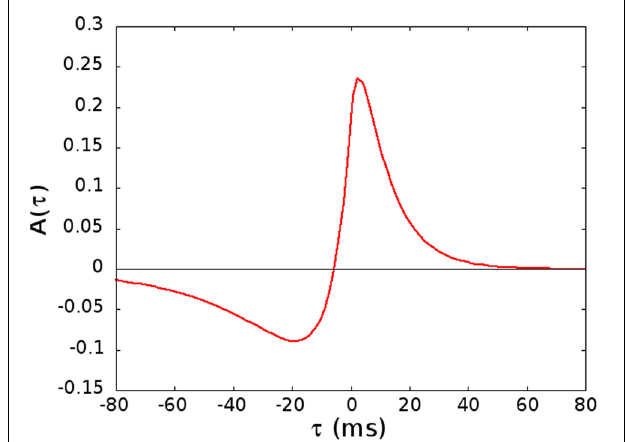
FIGURE 1 | The kernel A ( τ ) used in Equation (5), given by A ( τ ) = a p e − τ/ T p − a D e − ητ/ T p if τ > 0 and A ( τ ) = a p e ητ/ T D − a D e τ/ T D if τ < 0, with a p = [ 1 + η T p / T T D = 28 . 6ms, and η =